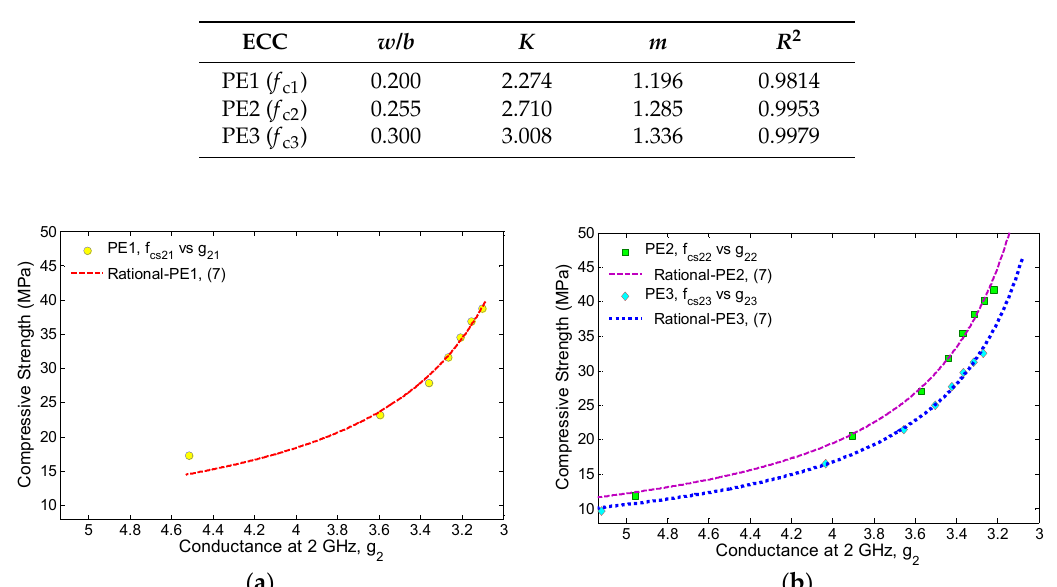
Table 6. Regression coefficients and qualities for Equation (7).